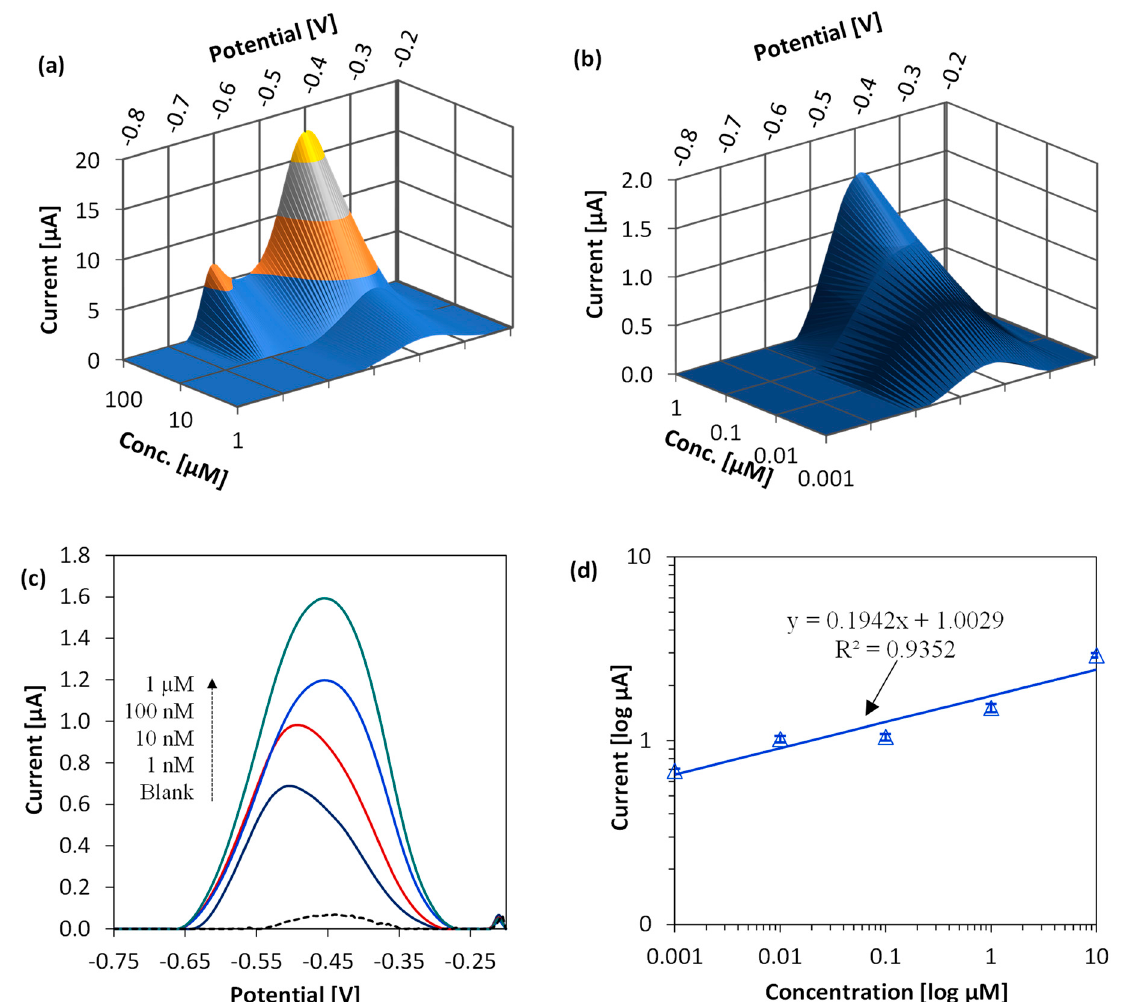
Figure 5. ( a , b ) ASV peak profile for 1 nM–100 µM Pb in deoxygenated acetate buffer (0.2 M, pH 5.2). ( c ) Anodic stripping voltammogram in 1 nM–1 µM Pb using parameters from Table 2. ( d ) Sensor calibration curve in buffer. Standard deviation obtained for n = 3.